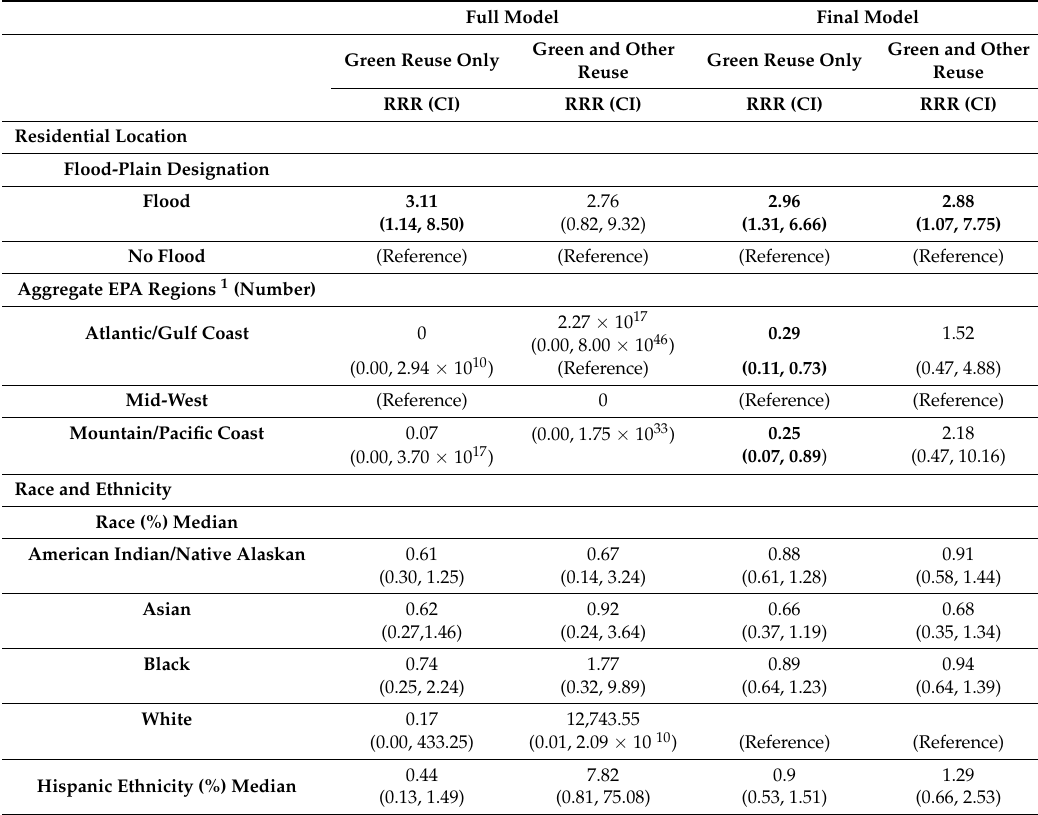
Table 5. Multivariable-interaction model of county brownfield green